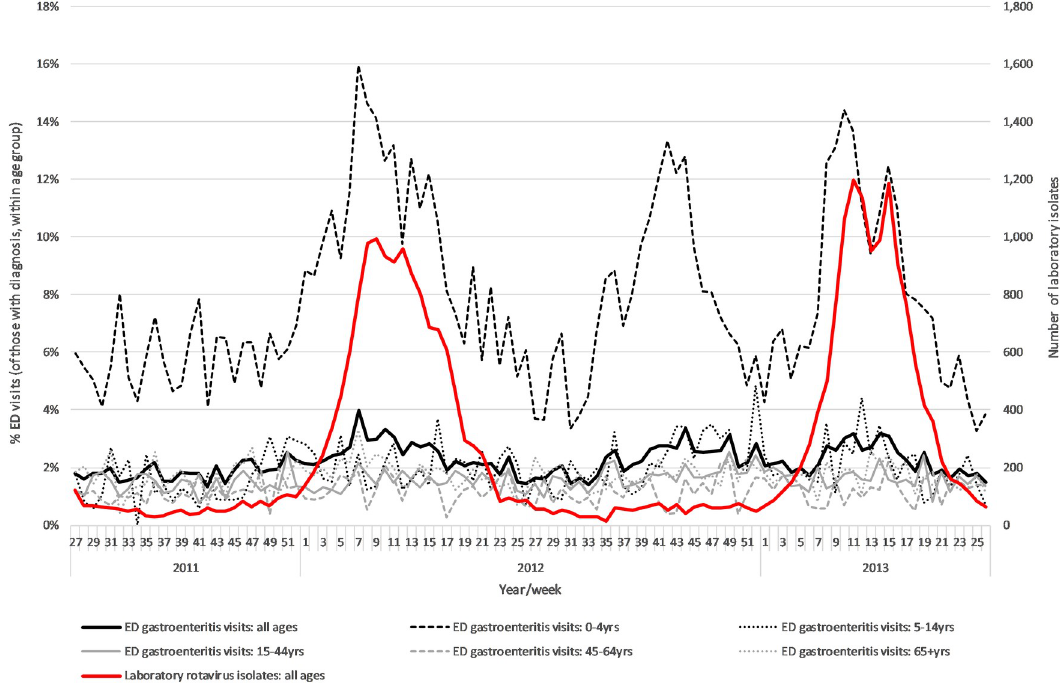
Fig 1. Weekly emergency department (ED) gastroenteritis visits (as a percentage of visits with a diagnosis), by age group and in total and weekly number of rotavirus laboratory isolations (England) during the two years pre-rotavirus vaccine introduction (2011 week 27–2013 week 26). Footnote: ED: emergency department; yrs: